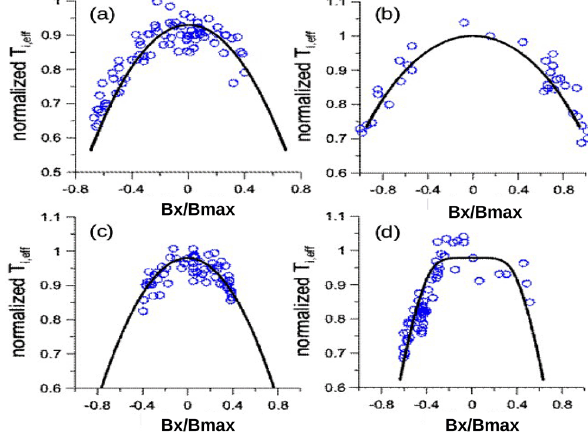
Figure 1. Comparison of four profiles of ion temperature measured in the magnetotail CSs (shown by blue circles) with model profiles (shown by black curves). See Catapano et al. (2015) for